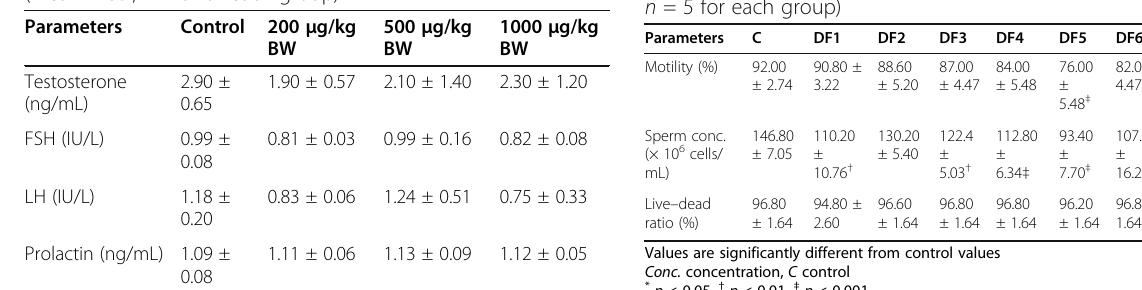
Reproductive effects of chromatographic fractions of